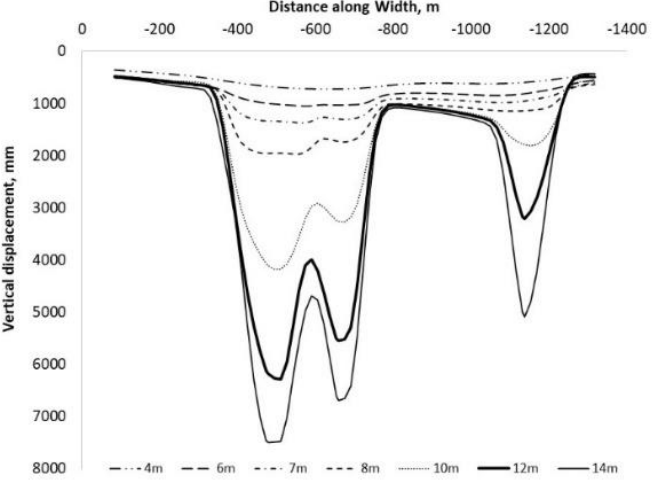
Figure 11. Vertical displacement at 270 m above the mining seam for various extraction heights.